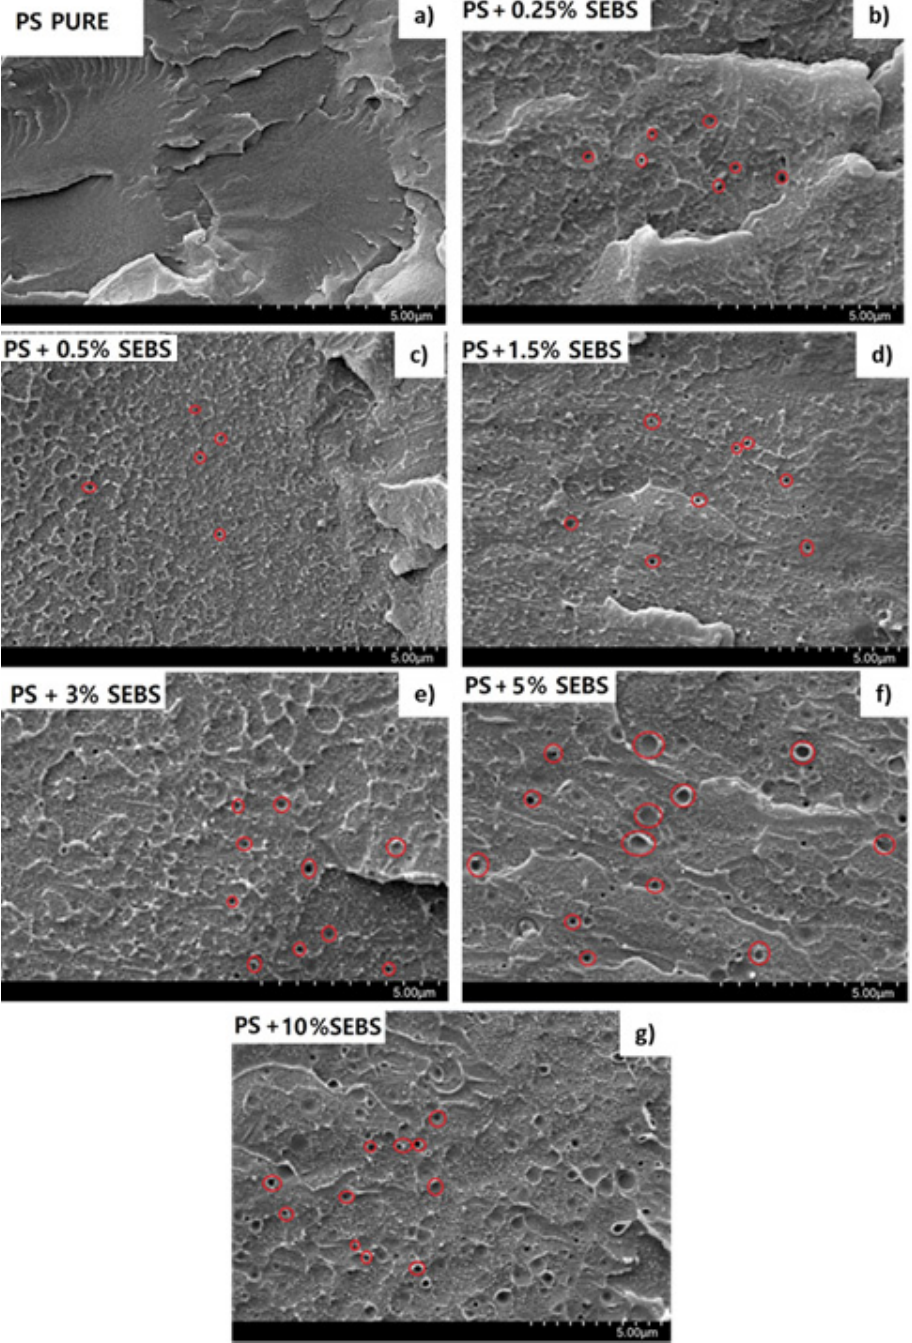
Figure 1. SEM micrographs of the solid formulations produced. ( a ) Pure PS; ( b ) PS +0.25% SEBS; ( c ) PS +0.5% SEBS; ( d ) PS +1.5% SEBS; ( e ) PS +3% SEBS; ( f ) PS +5% SEBS; ( g ) PS +10% SEBS. Red circles have been introduced to help with the visualization of the elastomeric phase.